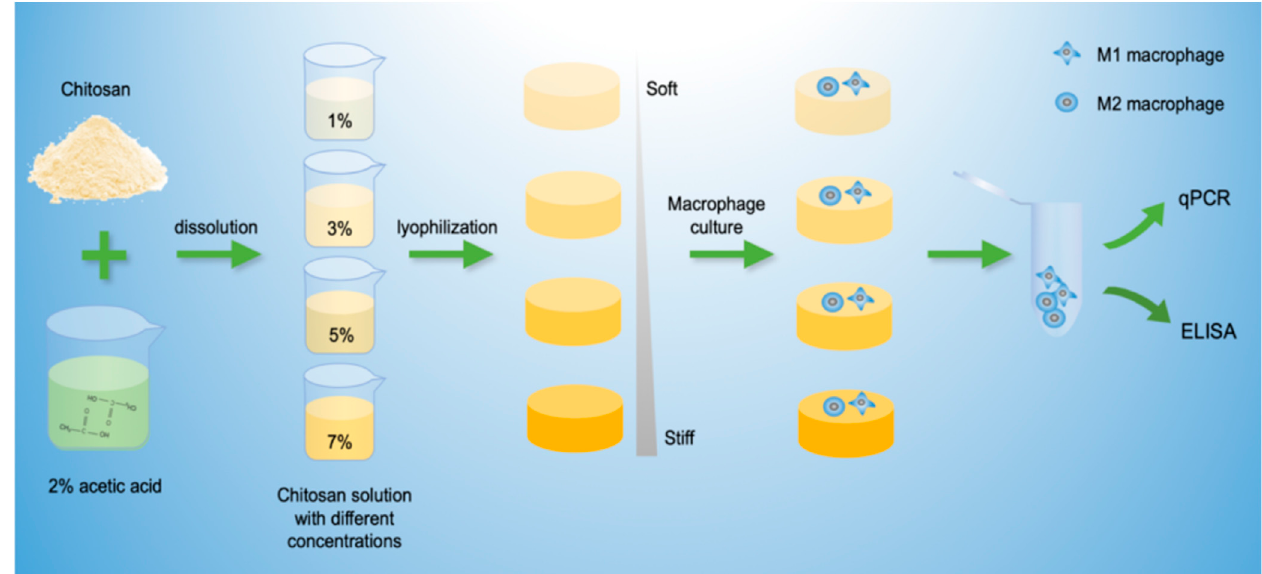
Figure 1. Schematic diagram of preparation of freeze-dried scaffolds with different elastic chitosan and study on the regulation of elasticity on macrophages.